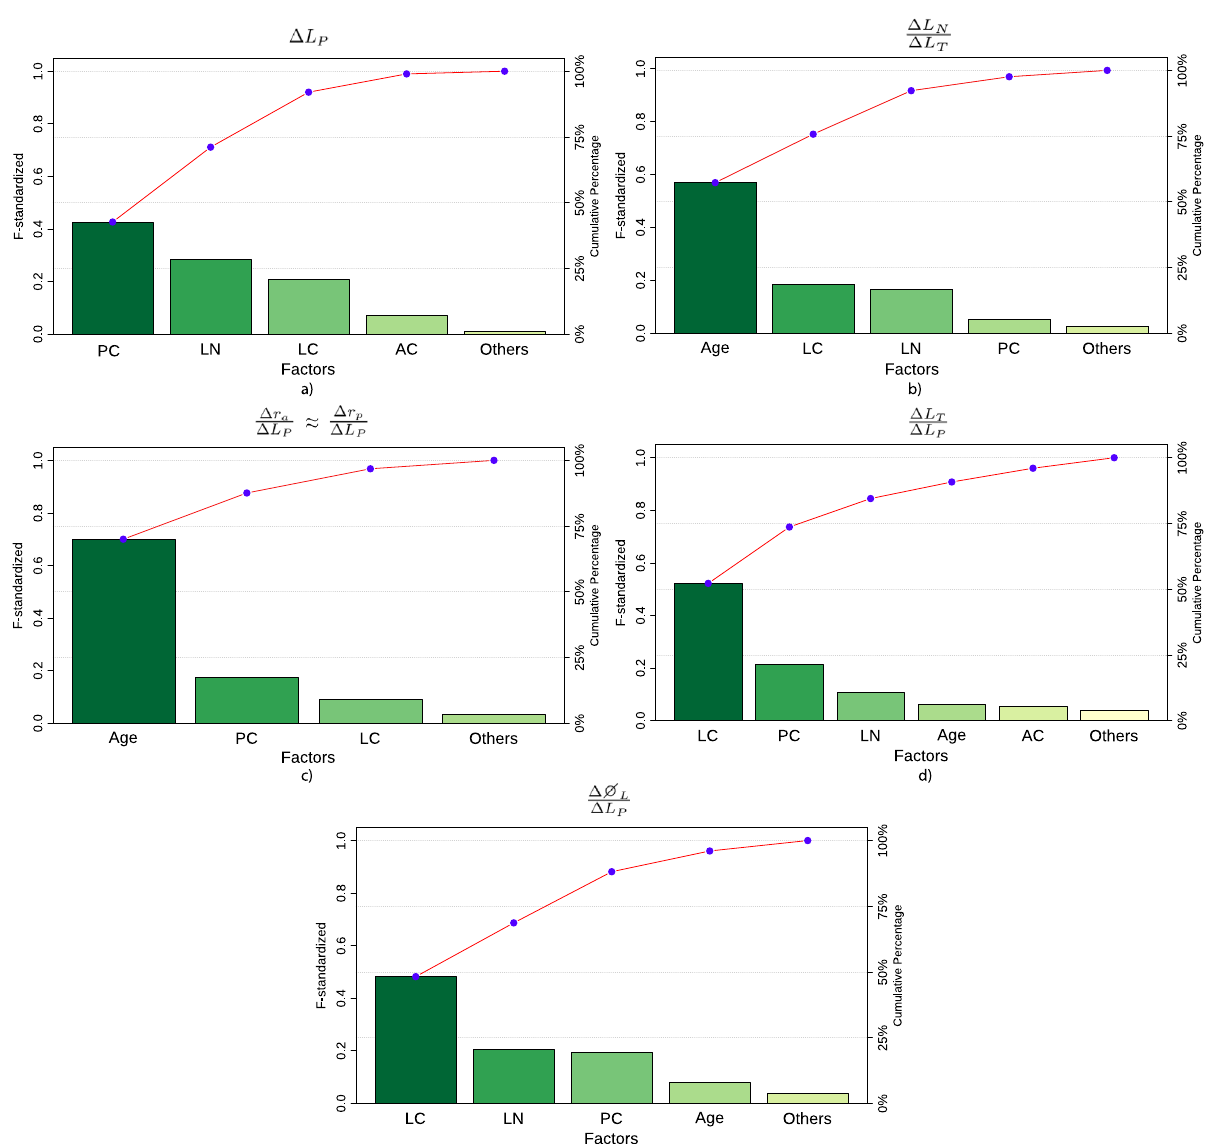
(cid:31) r p ( b ), (cid:31) r a (cid:31) L ( c ), (cid:31) L P P T